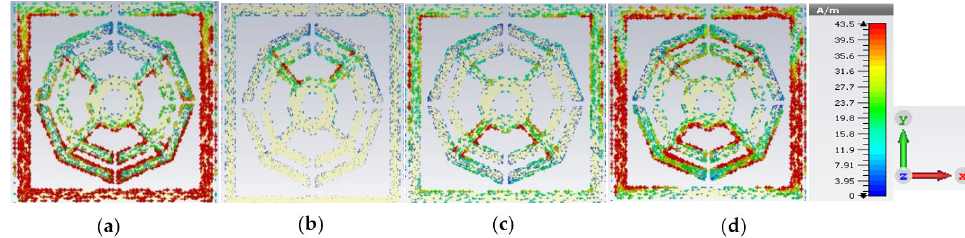
Figure 8. Surface current distribution at ( a ) 2.35 GHz, ( b ) 7.72 GHz, ( c ) 9.23 GHz and ( d ) 10.68. Time ‐ varying charge flow is mainly responsible for generating magnetic field accord ‐